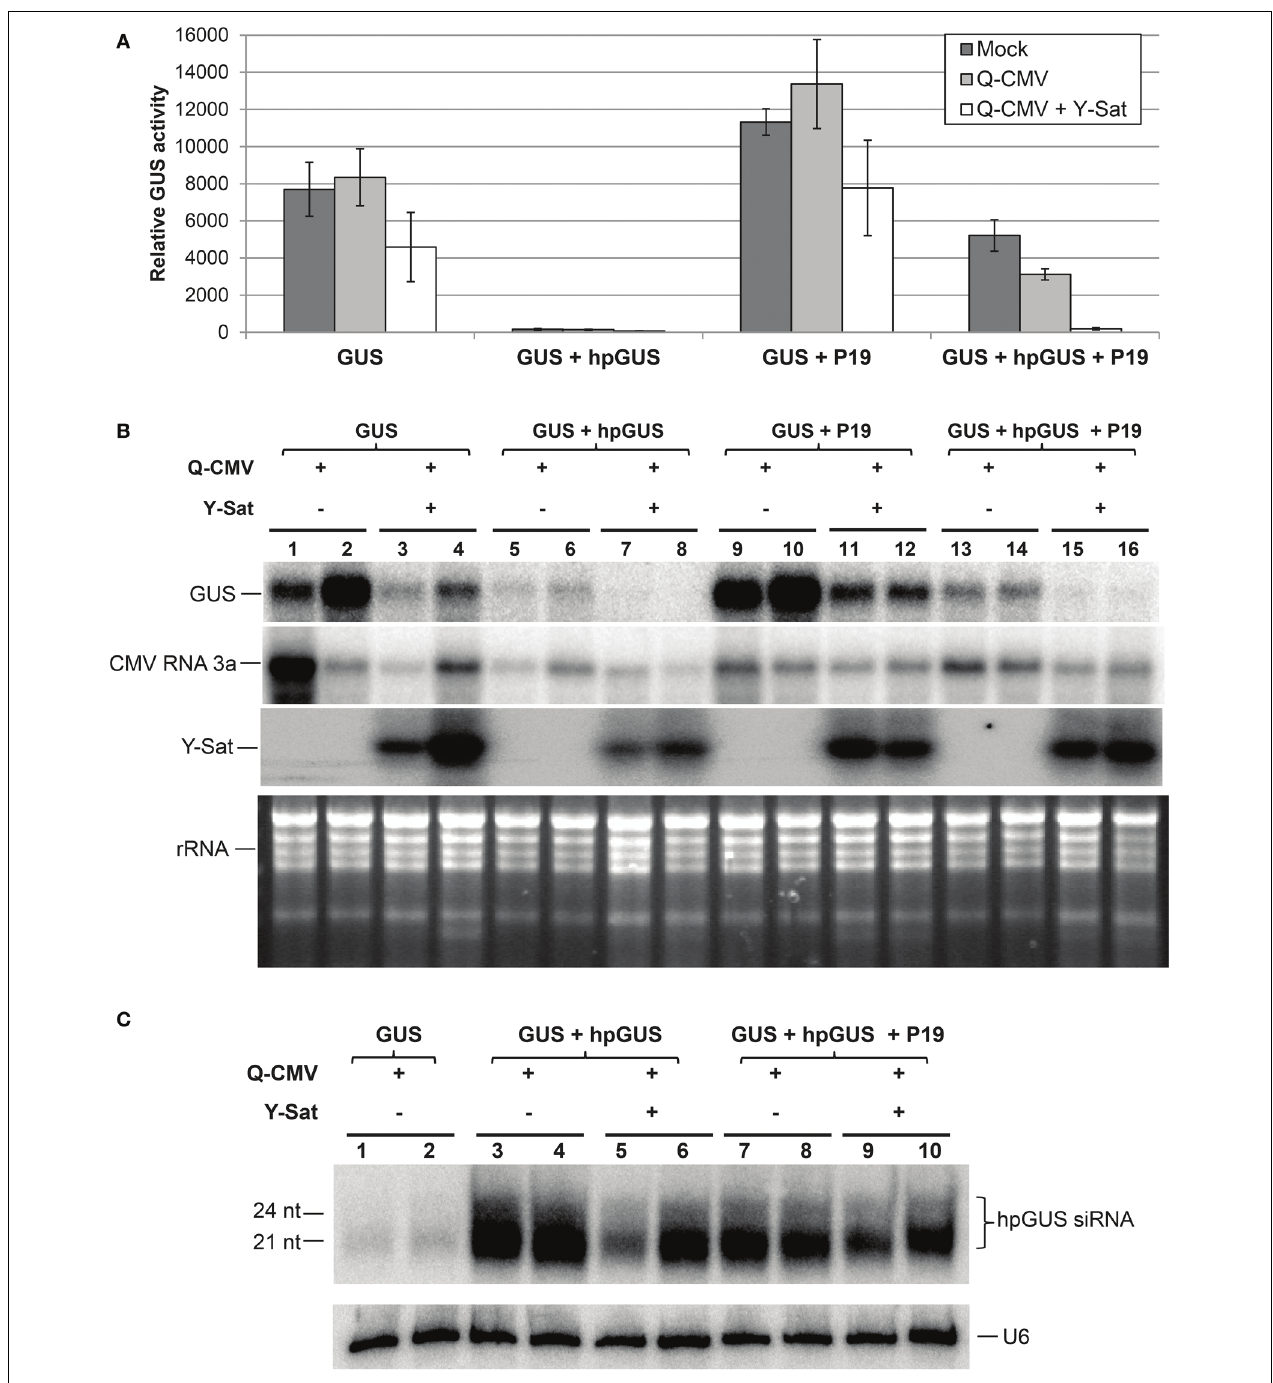
(third panel) in the agroinfiltrated tissues. Ethidium bromide-stained rRNA bands were used as loading control (bottom panel). (C) Northern blot hybridization analysis of small RNAs in a subset of the samples described in (A) . Ten microgram of total RNA each was hybridized with a RNA probe corresponding to the dsRNA stem region of hpGUS to detect hpGUS-derived siRNA (top panel) and a U6 probe to show loading control (bottom panel). The sizes of the detected siRNAs are indicated. As can be seen, the level of hpGUS -derived siRNAs is not significantly affected by Q-CMV Y-Sat